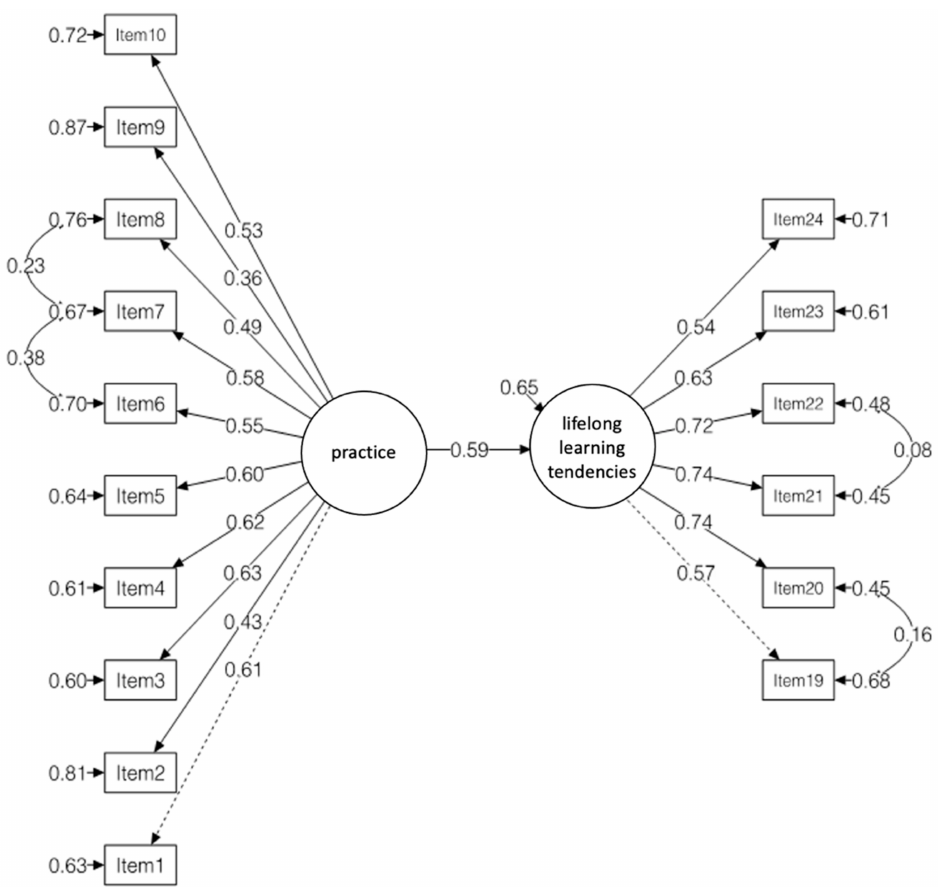
Figure 3. Practice opportunities give rise to opportunities to promote lifelong learning